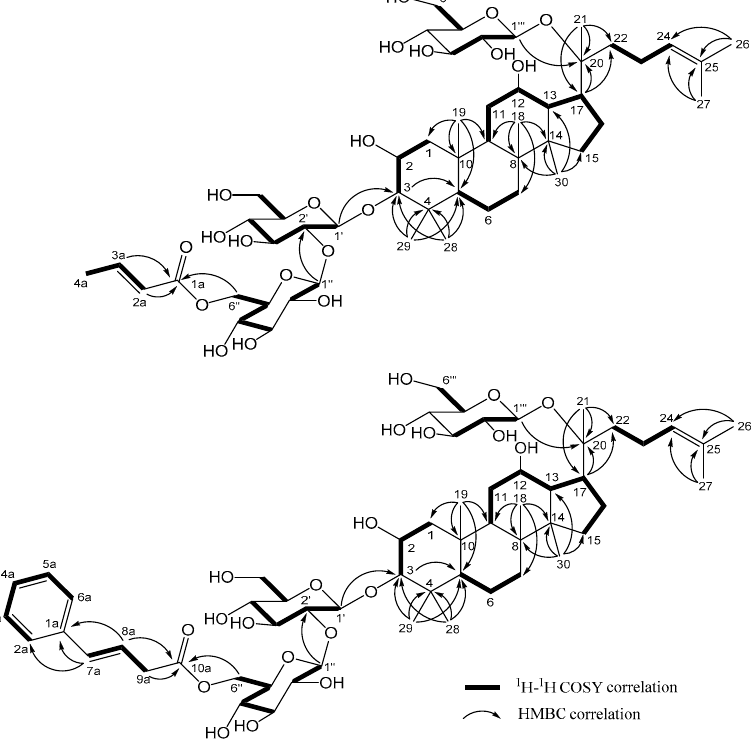
Figure 3. Key COSY and HMBC correlations of 2 and 5 .